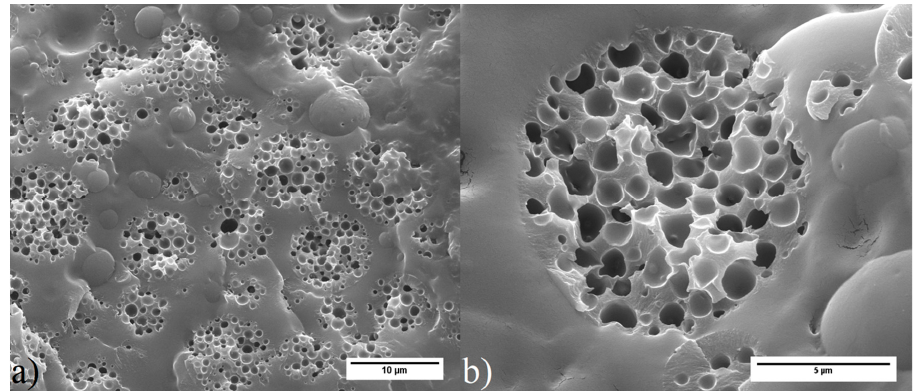
Figure 1. SEM images of MHP (magnification: ( a ) 4000x; ( b ) 16000x).